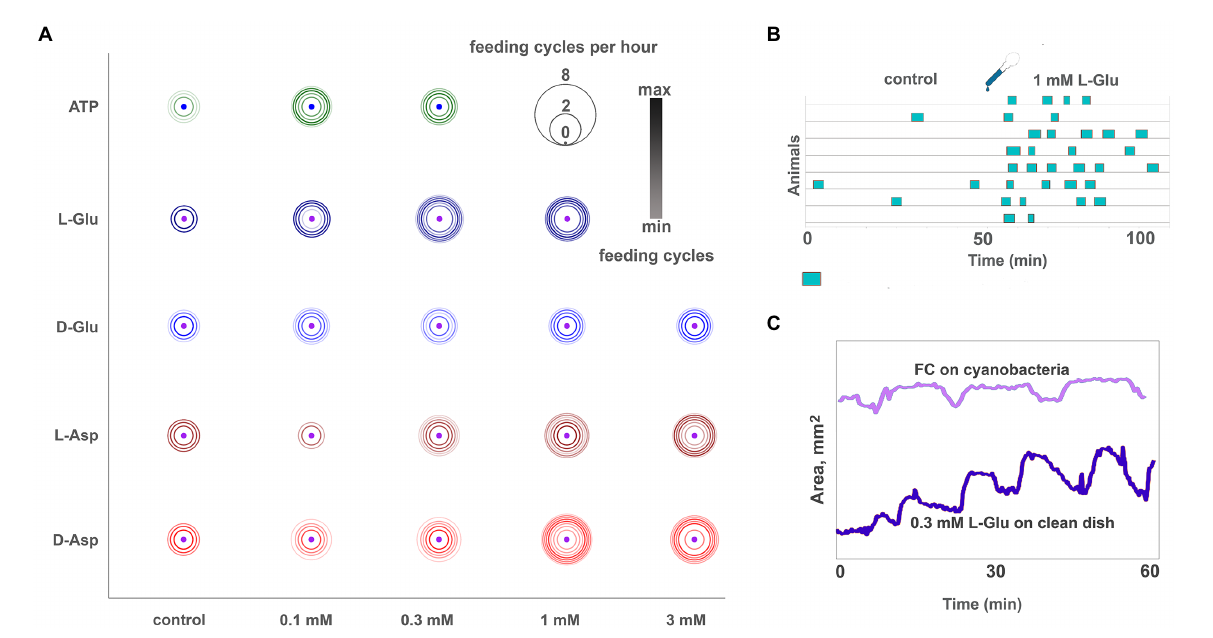
clean glass, 60 min straightness index (ST, see “Materials and methods”) was 0.32 ± 0.16 (median ± SD) in control. After adding 0.1 mM glycine, 60-min ST decreased to 0.22 ± 0.09 (Figure 8B). This